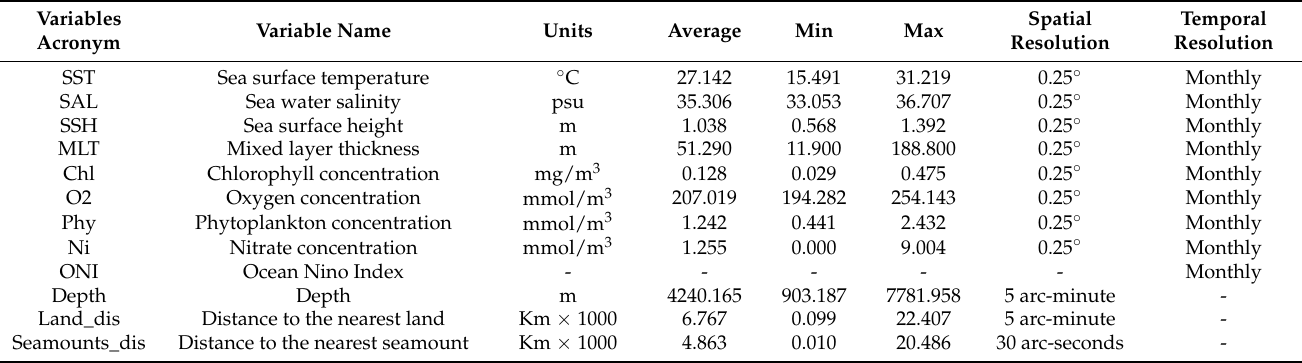
Table 1. Summary of the environmental